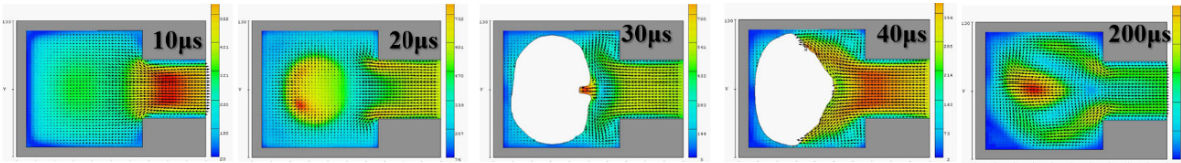
Figure 5. Calculate and simulate water in a single-channel jet cavity with a nozzle diameter of 60 μ m and a thickness of 50 μ m, with an operating frequency of 10 KHz, in the XZ two-dimensional cross-sectional view, at 10, 20, 30, 40, 100, 110, 120, 130, 140 and 200 μ s injection situation.